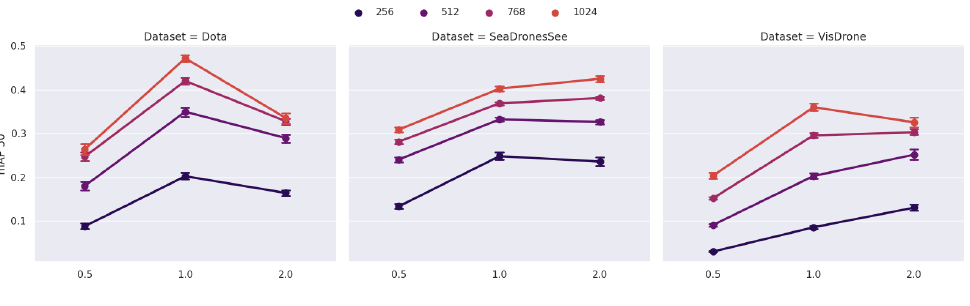
Figure 8. Image Size: Faster R-CNN trained with different training image sizes and validated on validation image size = x × training image size. The y-axis shows the mean Average Precision